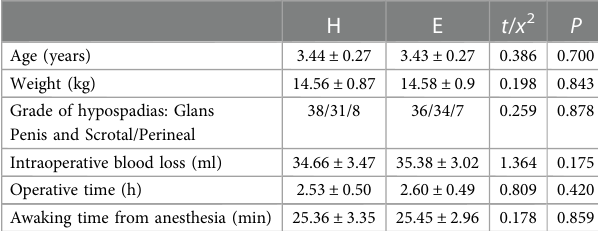
TABLE 2 Postoperative